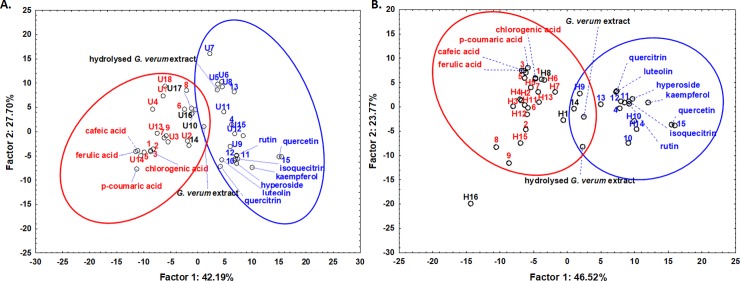
Phytoconstituent classification based on spectral similarities after chromatographic separation.Score plots of the first two principal components after applying PCA on the UV-vis mean spectra of the chromatographic peaks obtained by HPLC analysis of G. verum extract prior hydrolysis (A) and after hydrolysis (B). The UV-vis spectra of the two extracts, before separation and the standards are also indicated in both plots. The letter U stands for “unhydrolysed” and indicates compounds specific for this extract; the letter H stands for “hydrolysed” and indicates compounds found only in the hydrolysed extract, while the numbers lacking a letter indicate compounds that are found in both extracts. The number is attributed according to the retention order; the compounds are listed in Table 2.